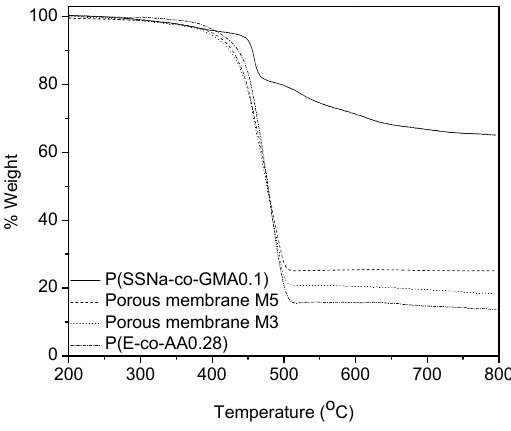
Figure 6. TGA analysis of the PE- g -PSSNa porous membranes and the copolymers P(ethylene- co -A Α 0.28) and P(SSNa- co -GMA0.1).